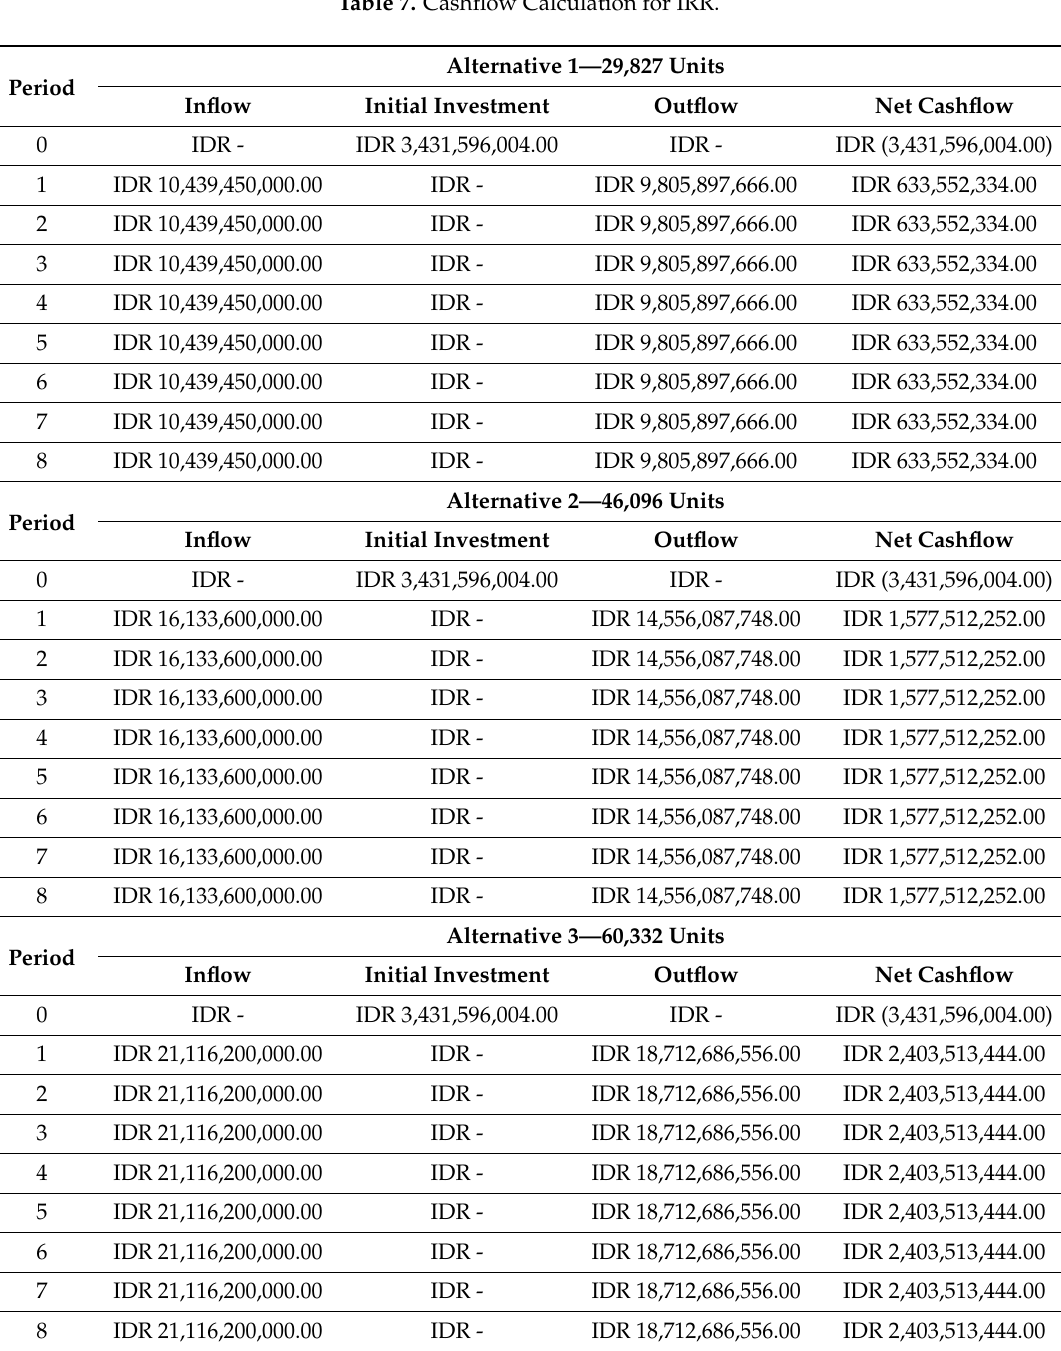
Table 7. Cashflow Calculation for